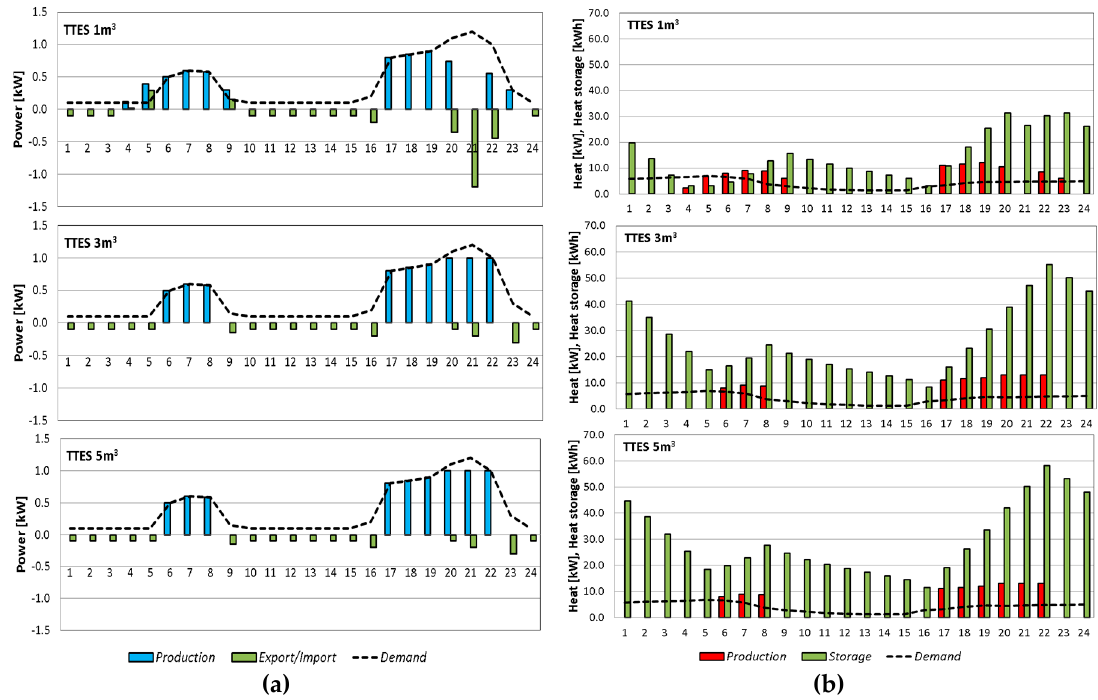
Figure 11. Comparison of the electricity demand and production ( a ), and heat demand, production, and storage ( b ) in the mCHP system, which used the new algorithm for three different tank sizes during the spring season.